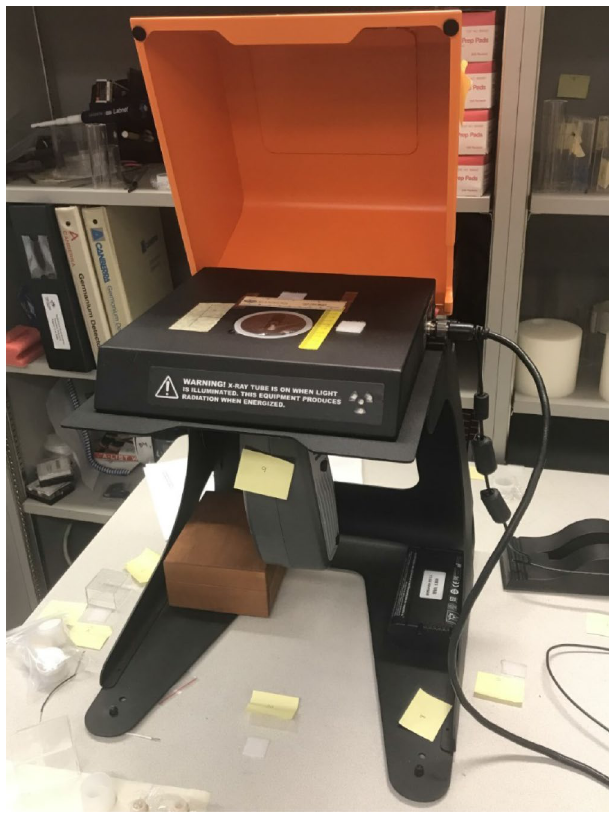
Fig. 1 The portable XRF system when operated in a tabletop mode. Here, the radiation pro- tection lid is shown open and ready for sample